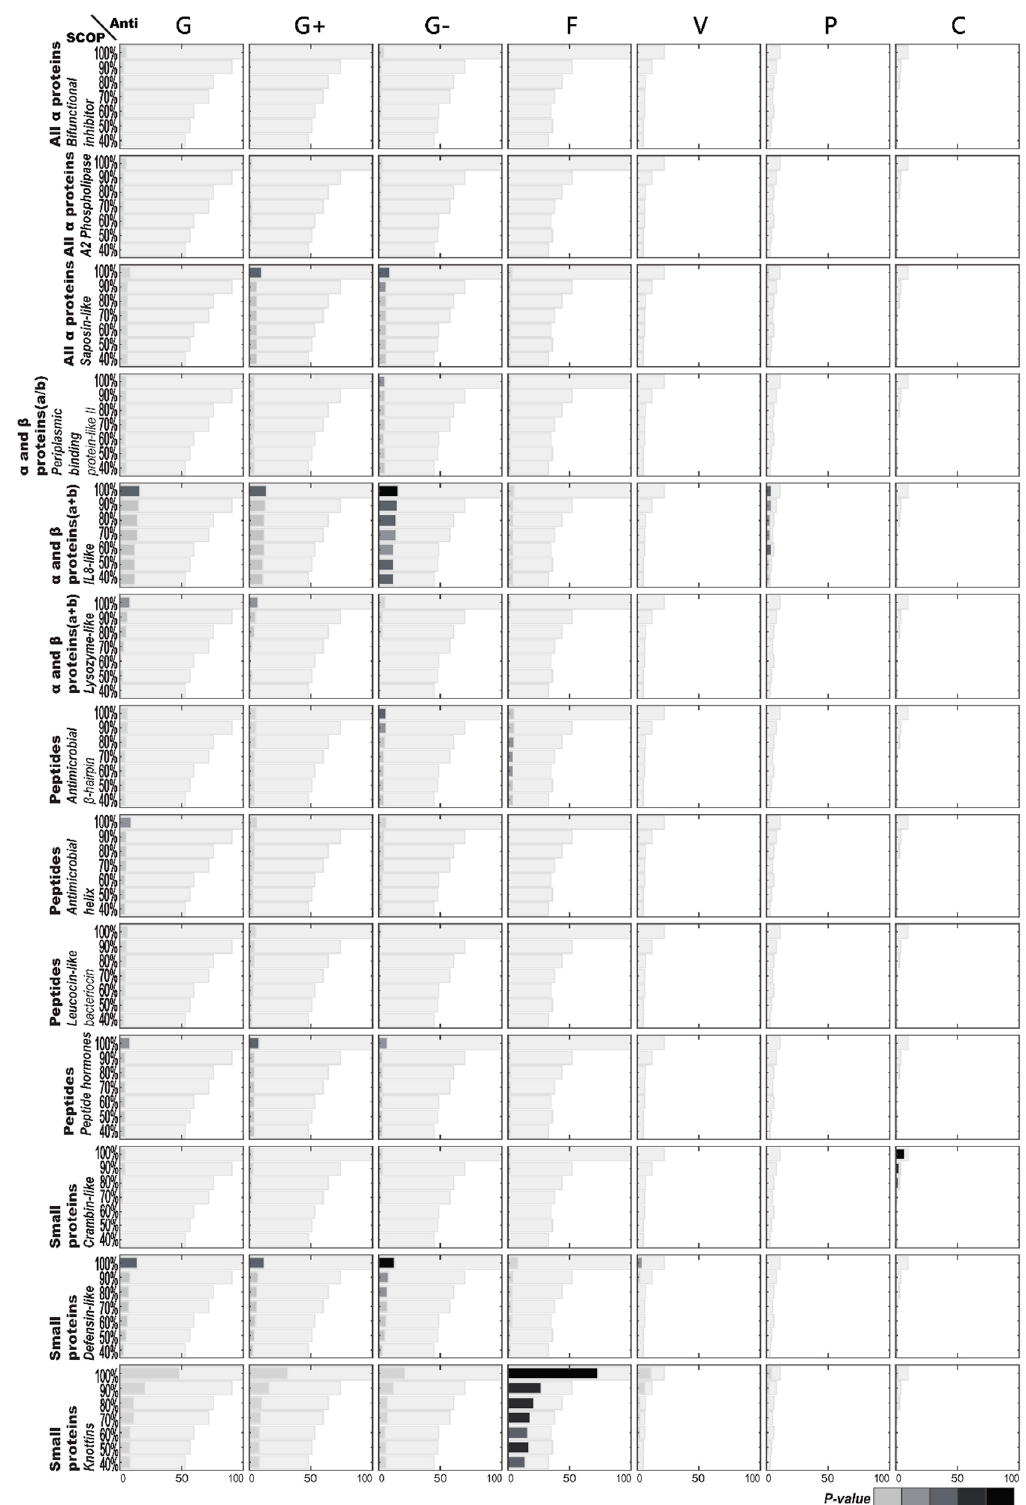
Figure 5. SCOP structural enrichment analysis of antimicrobial peptides (AMPs) with respect to their functions. The X -axis and Y -axis are, respectively, the number of AMP sequences and the percentage of sequence identity. The bar in light gray indicates the potential maximum number of AMP sequences with the specific structure. Abbreviations: C, anticancer; F, antifungal; G, antibacterial; G+, anti-Gram+; G-, anti-Gram-; P, antiparasitic; V, antiviral.